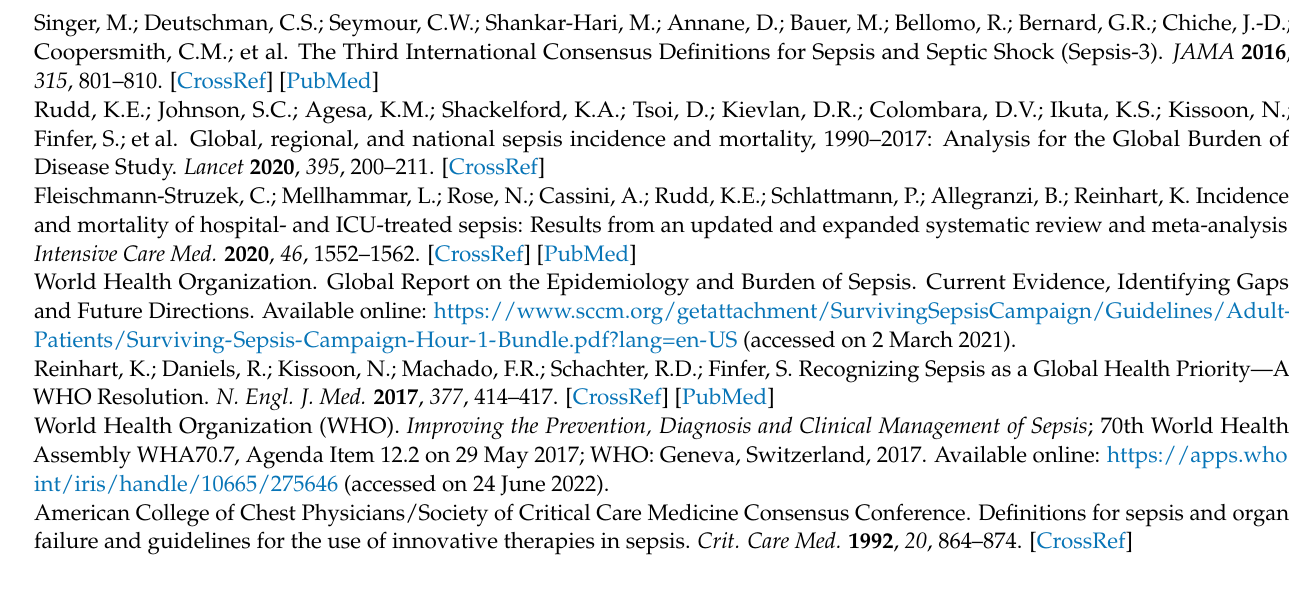
antibiotic prescribed. Table S1: Type, frequency, and percentage of 602 causative pathogens detected from 435 patients with